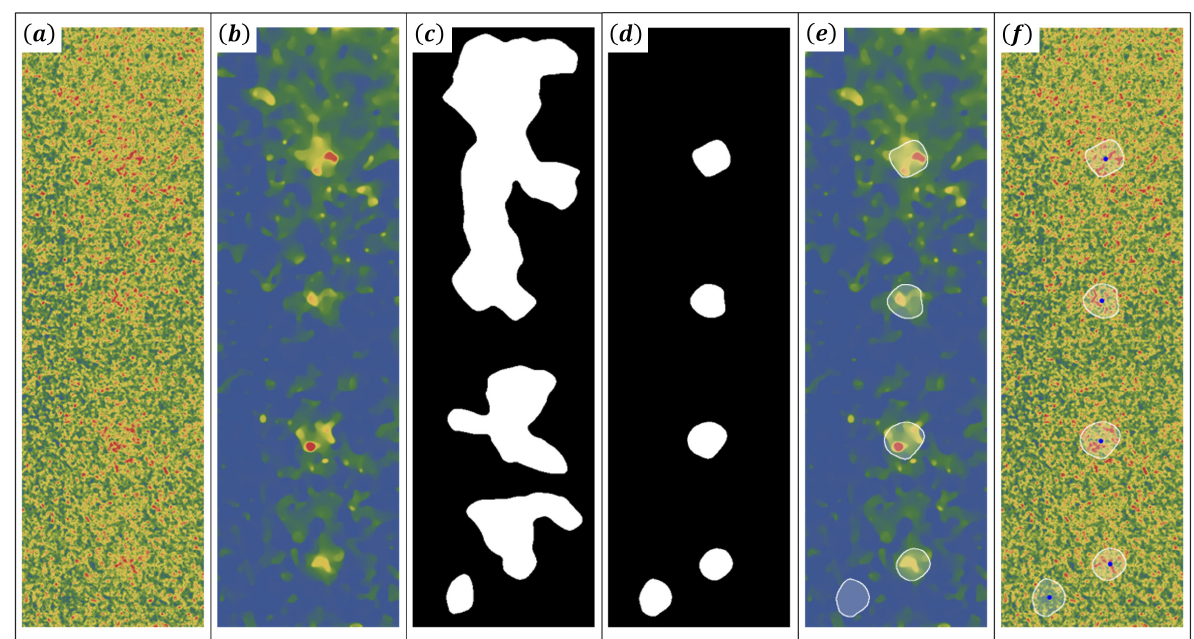
Figure 12. Another example of MRIF resolving initially occluded and incorrectly detected segments. Sub-figures ( a – d , f ) correspond to Figure 11a–e, respectively, and ( e ) shows the MRIF output overlays for the global filter output. The false positive in the bottom-left corner of ( d – f ) that survived MRIF interrogation will be eliminated by Algorithm 6, since it corresponds to background ( e ).